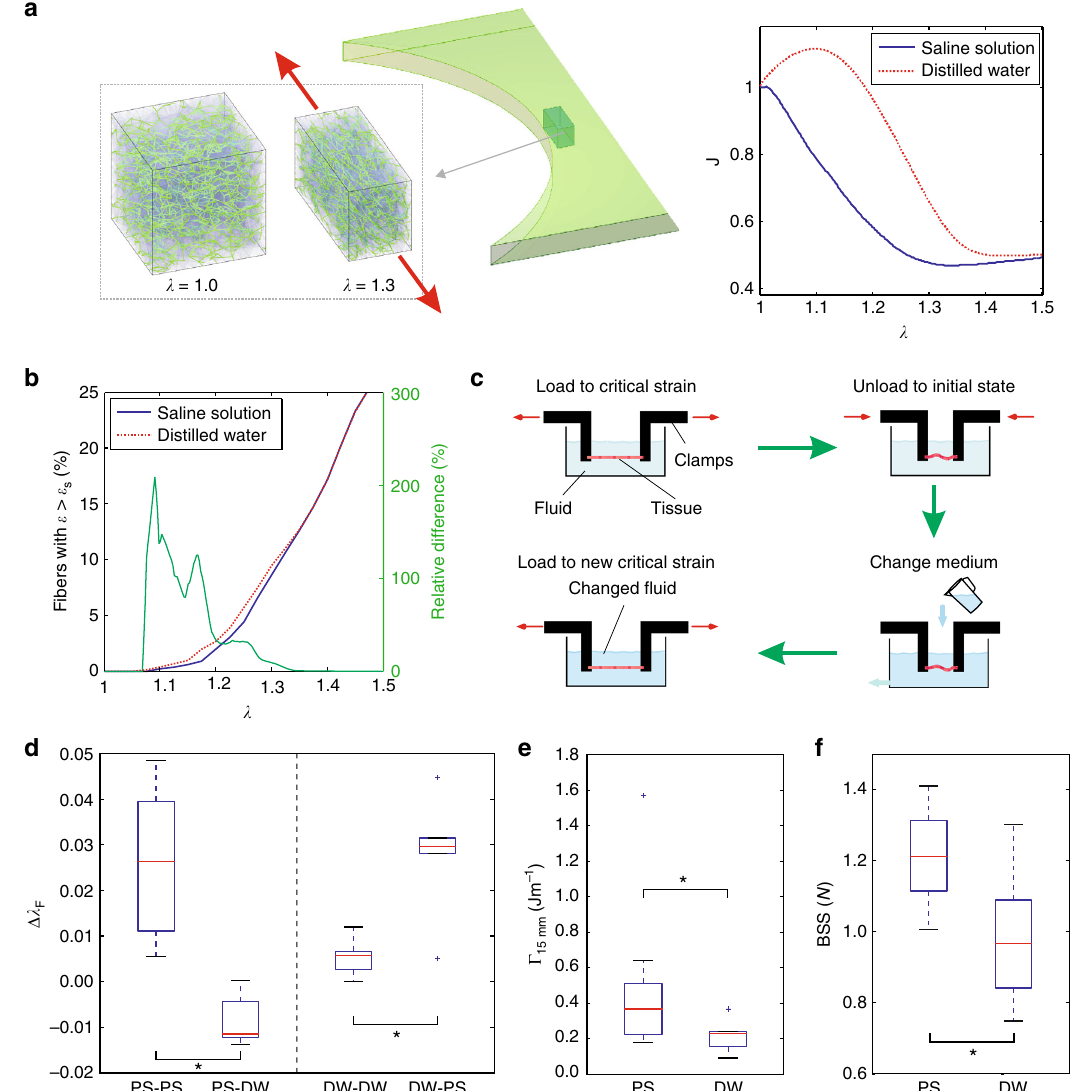
Fig. 5 Osmolarity of the liquid environment in fl uences the toughness of SCT. a Illustration of the 3D discrete fi ber network model with volumetric chemoelastic contributions used to analyze the network deformation in the near fi eld of the notch. Reference and elongated states are shown, together with the volume change J vs. λ curves. b The in fl uence of bath osmolarity on the network kinematics at the notch tip is quanti fi ed in terms of the relative fraction of fi bers with a strain larger than their slackness (5%). c Schematic illustration of the experimental procedure used for the investigation of the sample speci fi c effect of bath osmolarity on fracture behavior of SCT. GC testpieces were immersed in physiological saline solution (PS) and in distilled water (DW), were elongated up to the point of crack propagation, then unloaded, after which the bath was either changed or not, before reloading to crack propagation. d Sample-speci fi c difference in critical stretch Δ λ F between subsequent loadings with (PS-DW, n = 5, and DW-PS, n = 5) or without (PS-PS, n = 6, and DW-DW, n = 7) bath change. e Experimentally determined tearing energy of GC in PS ( n = 9) and DW ( n = 5). f Suture retention strength tests on GC leading to smaller BSS in DW ( n = 7) than in PS ( n = 7). Results in ( d – f ) are presented as boxplots, where boxes represent upper and lower quartiles and lines inside the boxes de fi ne the median, while dots represent outliers, and whiskers 10 – 90 percentiles. Signi fi cant differences are indicated for p < 0.05 by * (Student t